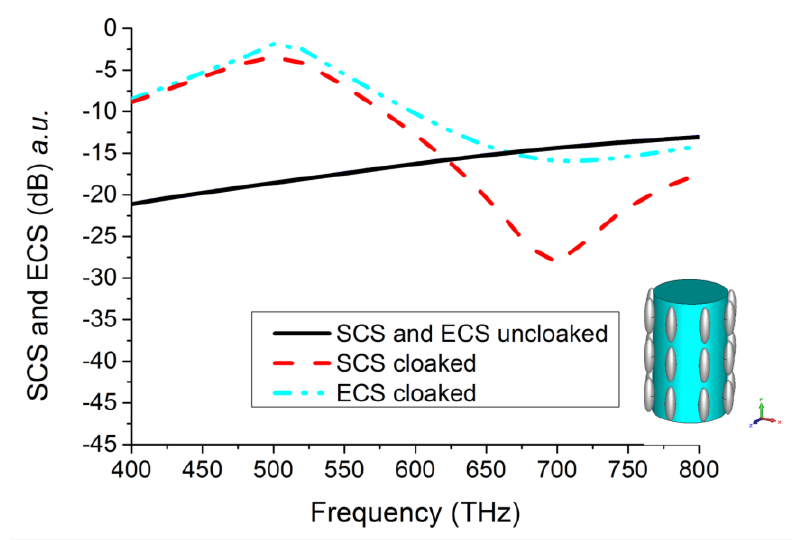
Figure 8. Scattering cross section (SCS) and extinction cross section (ECS) of the third coated cylinder compared to the one of uncloaked cylinder.